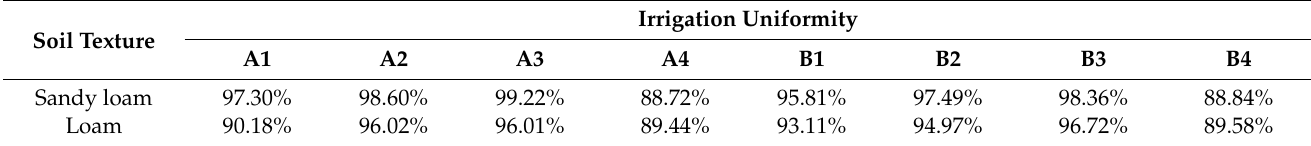
Table 3. Irrigation uniformity under different